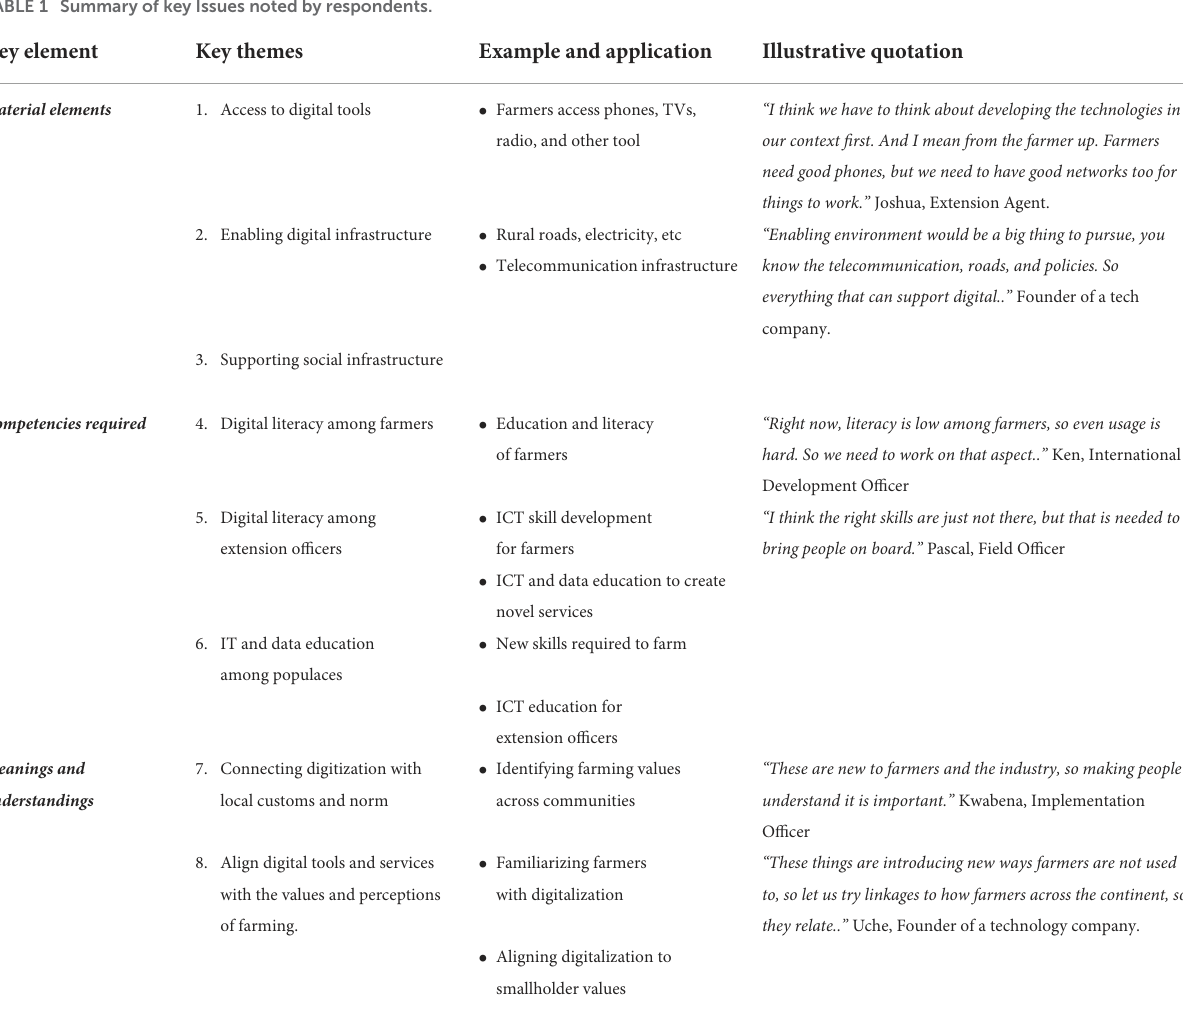
TABLE 1 Summary of key Issues noted by